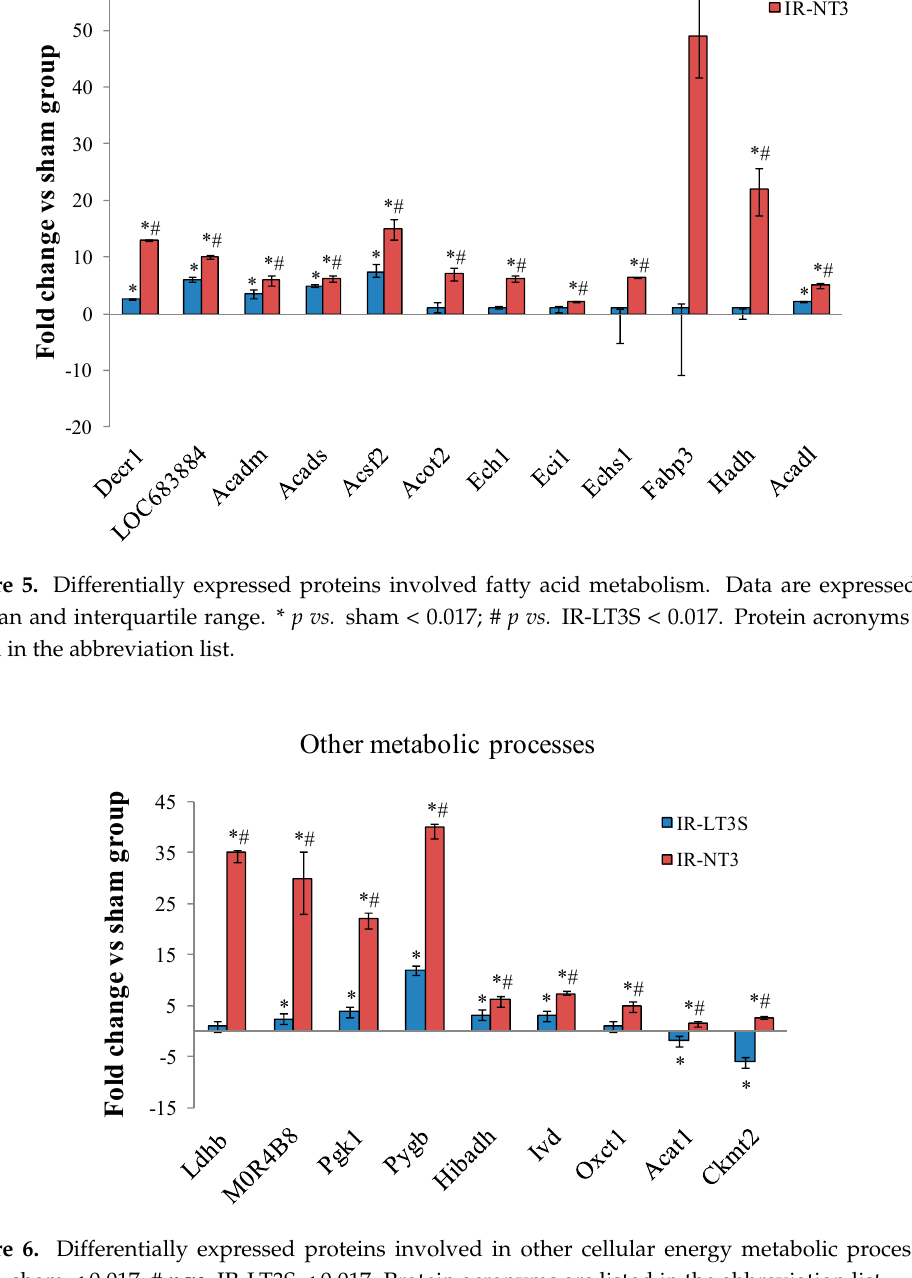
Figure 6. Differentially expressed proteins involved in other cellular energy metabolic processes. * p vs. sham < 0.017; # p vs. IR-LT3S < 0.017. Protein acronyms are listed in the abbreviation list.